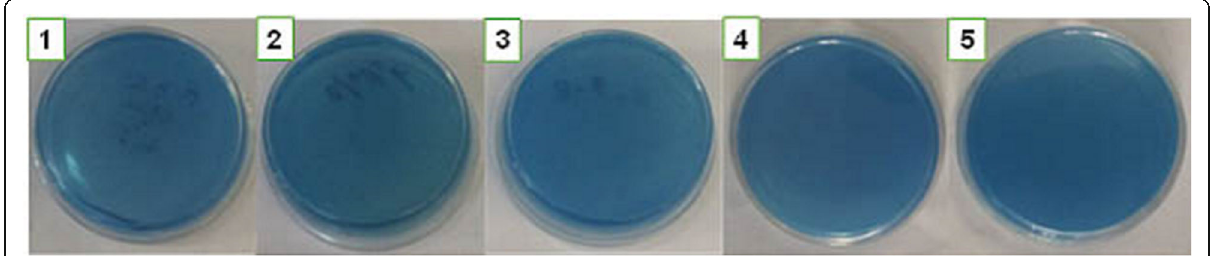
Fig. 4 Nitrogen fixation capacity of the selected Pseudomonas isolates. 1: 8312, 2: 642, 3: 4532, 4: 1111, 5: